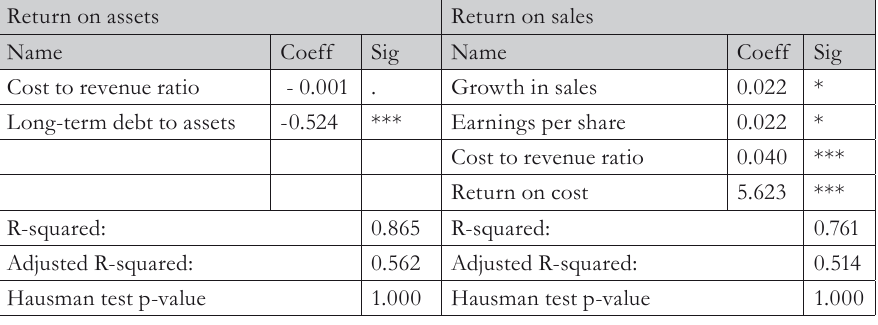
Tab. 6 - Mining sector: significant variables predicting ROA and ROS. Source: author’s own